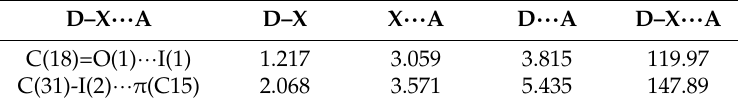
Figure 2. The cocrystal structure: ( a ) 1D chain motif. ( b ) Arrangement of the 1D chains with opposite chirality. ( c ) 3D structure of the cocrystal. Hydrogen atoms not participating in the interactions have been omitted for clarity. Table 2. Halogen bonds geometry (Å, deg) for the cocrystal.